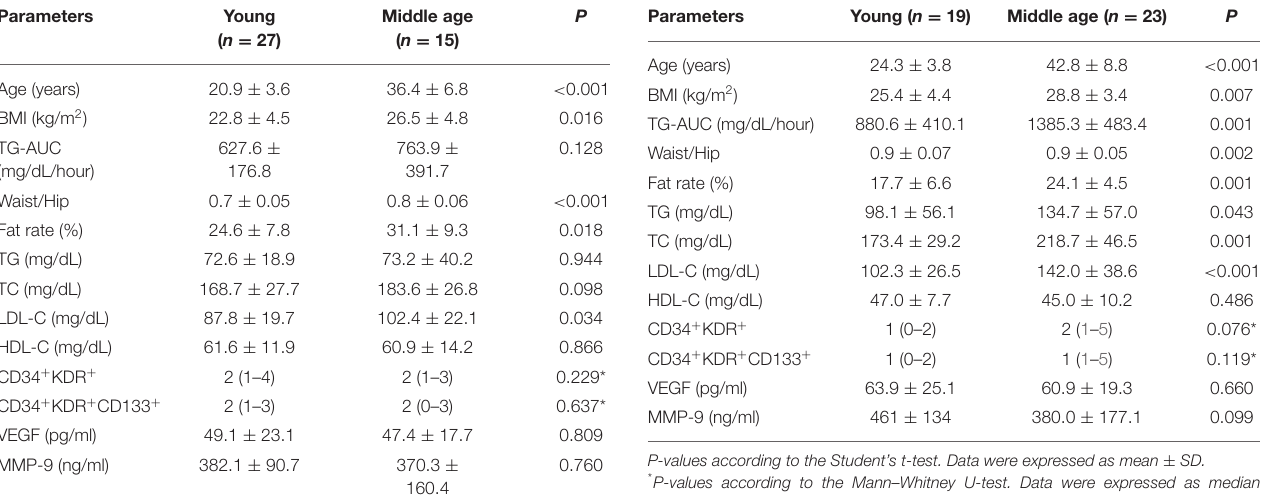
TABLE 5 | Physical characteristics and biochemical and immunological parameters according to the age in men.